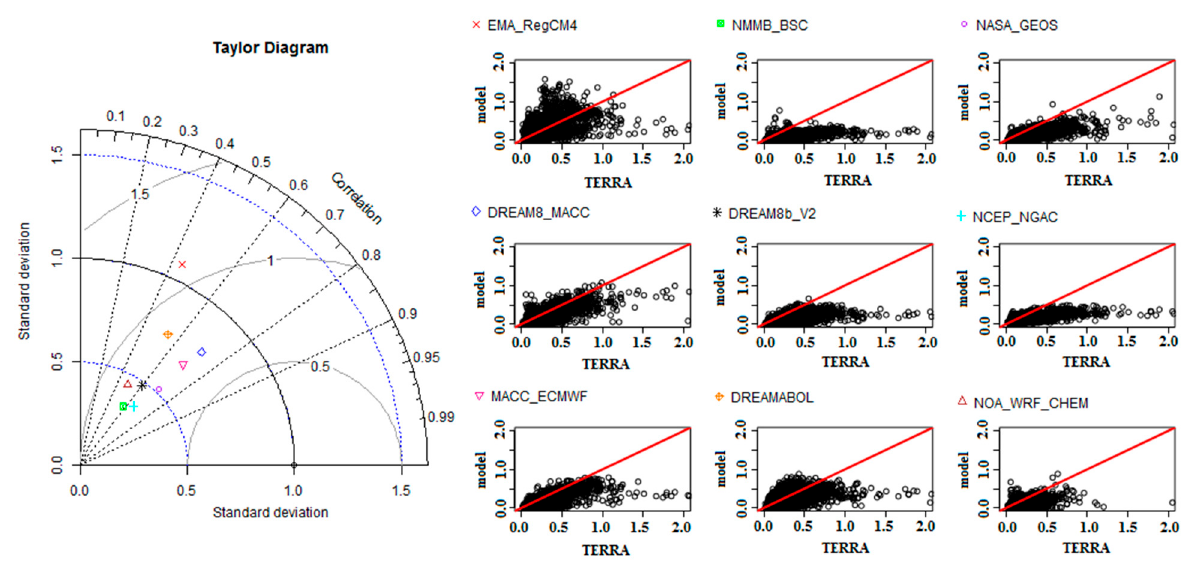
Figure 8. Taylor diagram and scatter plots of AOD values from model outputs and Terra-MODIS observations over the Middle East during cyclonic dust storms. Table 2. Statistical results (r, p -value and RMSE) from the evaluation of the forecasted AODs of each model against MODIS-AODs over the Middle East during dust events of various types. Cyclonic Post-Front Pre-Front Model